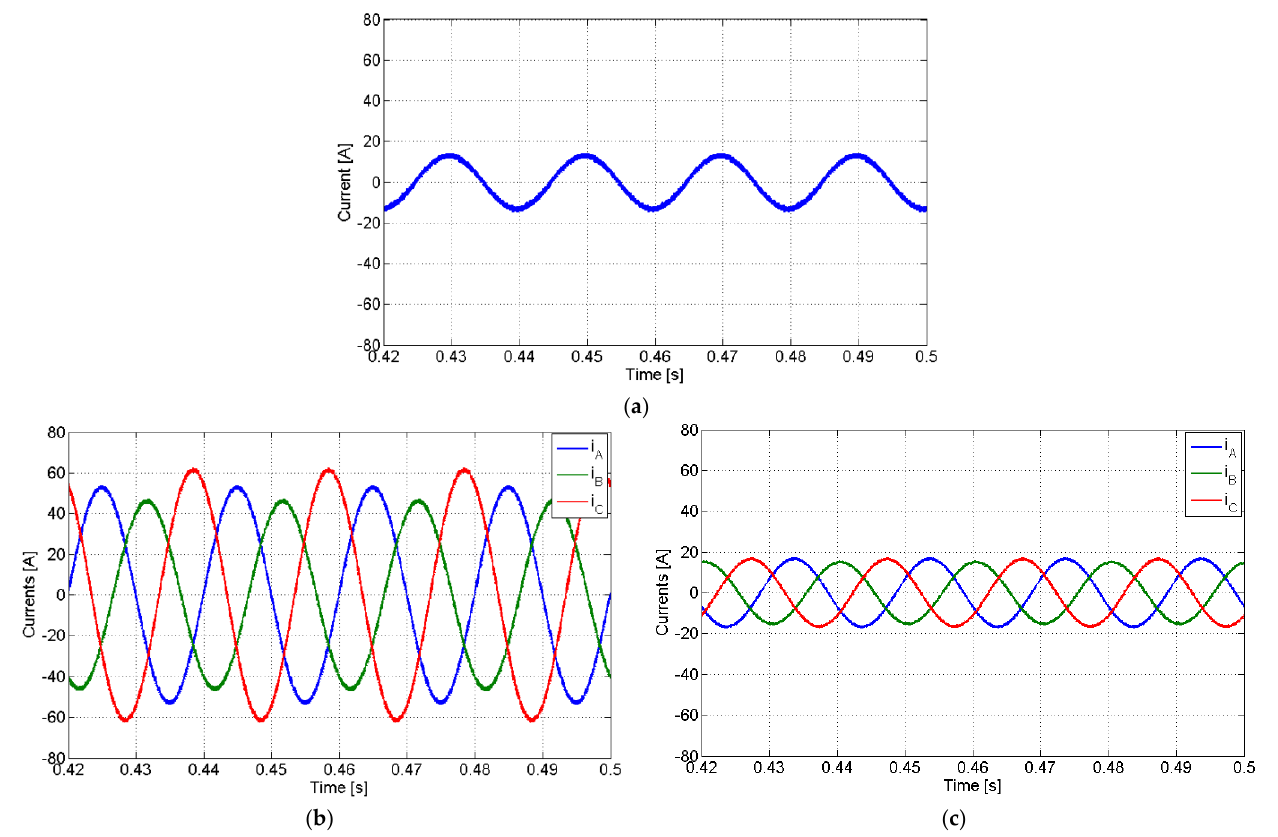
Figure 12. Simulation results with the PV generator in overcompensation mode with a linear load and compensation of the active power imbalance: ( a ) current in the in the line between the fourth leg of the inverters; ( b ) AC currents of the PV generator; ( c ) grid currents.